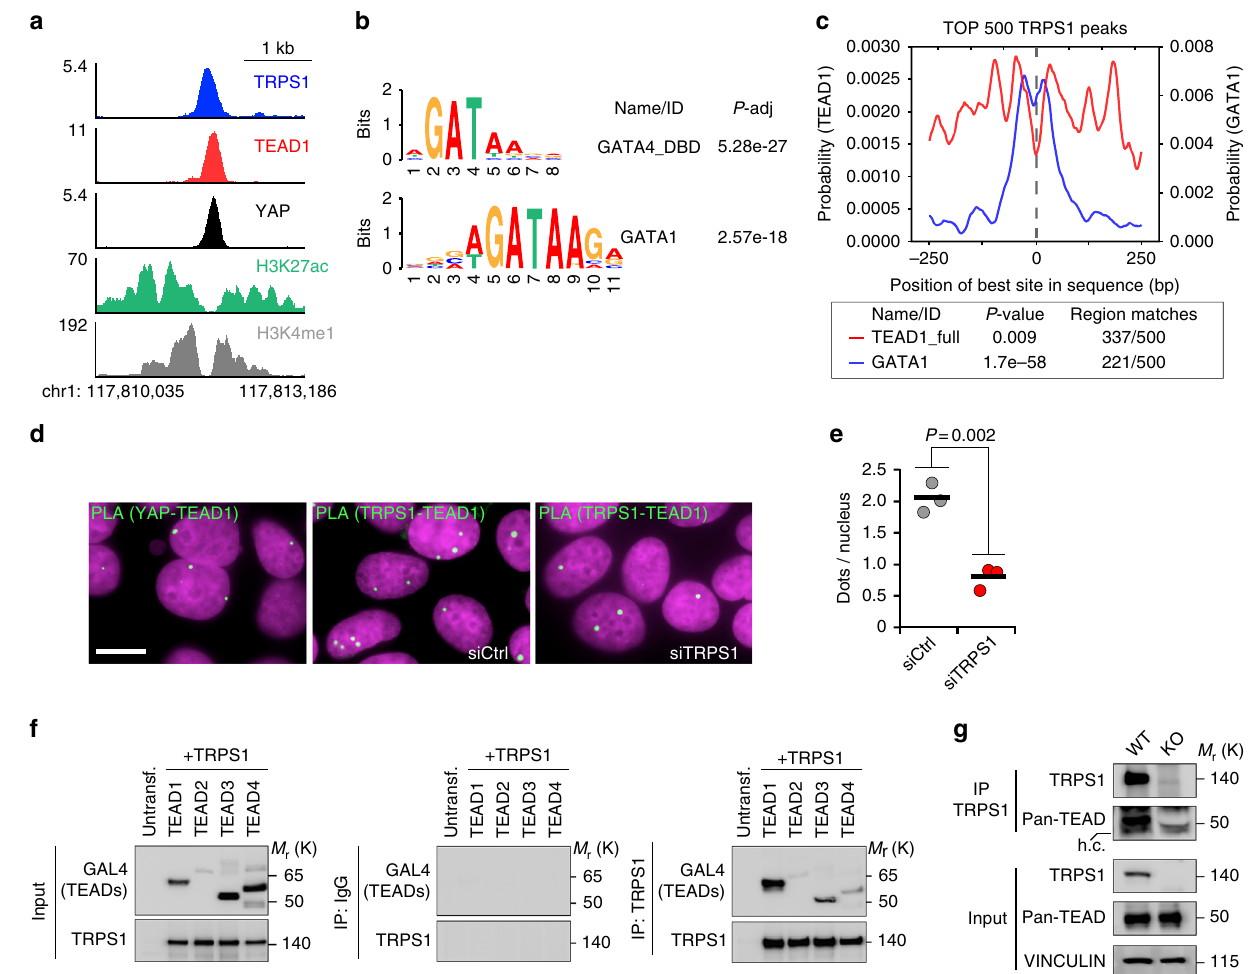
Fig. 4 TRPS1 gets recruited to TEAD sites by cooperative binding. a ChIP-Seq tracks for TRPS1, TEAD1, YAP, H3K27ac and H3K4me1 at the VTCN1 Enhancer region. b Motif enrichment analysis (DREME) for GATA4 and GATA1 binding sites in TRPS1 ChIP peaks. c Centrimo analysis for GATA1 and TEAD1 motifs to identify enriched binding sites surrounding the Top 500 TRPS1 ChIP-Seq peaks. d Representative pictures from proximity ligation assay (PLA) experiments in MCF7 cells. The pictures show PLA signals (in green) for YAP and TEAD (positive control, left) or TEAD1 and TRPS1 after treatment with siRNAs targeting TRPS1 or control siRNAs (siCtrl). e Quanti fi cation of PLA signals for the TEAD1-TRPS1 interaction in MCF7 cells treated with siTRPS1 or siCtrl, respectively. Values are presented as the number of dots per nucleus for each of the three biological replicates. A horizontal bar indicates the average. For quanti fi cation, at least 400 cells per replicate were counted. Student ’ s t -test. f Co-immunoprecipitation experiment from 293T cells co- expressing TRPS1 and the indicated GAL4-tagged TEAD proteins. The lysates were subjected to immunoprecipitations using a TRPS1 antibody or IgG as a control and subsequently analyzed by Western blot. IgG controls and TRPS1 precipitates were analyzed on the same membrane. g Endogenous co- immunoprecipitation experiment from MCF7 WT and KO TRPS1. The lysates were subjected to immunoprecipitations using a TRPS1 antibody and subsequently analyzed by Western blot using a Pan-TEAD antibody; h.c. heavy (Supplementary Fig. 5c). The TRPS1-mediated repression was dependent on the presence of GATA motifs in the ANKRD1 promoter, since TRPS1 was not able to repress a truncated ANKRD1 promoter lacking GATA sites ( ANKRD1 Δ GATA) (Supplementary Fig. 5d). Thus, the ability of TRPS1 to repress YAP/TEAD-dependent target sites is probably dictated by at least two factors: fi rst, a GATA-binding site located in close proximity to from a difference of compartmentalization between the control a YAP/TEAD site; second, a protein – protein interaction between and TRPS1 protein. We fi rst veri fi ed that BirA*-Flag-TRPS1 and TRPS1 and TEAD transcription factors. NLS-BirA*-Flag were both able to induce nuclear biotinylation of target proteins in a time-dependent manner upon biotin addition (Supplementary Fig. 6a, b). After the expression of BirA*-Flag- TRPS1 or NLS-BirA*-Flag, cells were treated with biotin for 18 h, biotinylated proteins were pulled down with streptavidin beads and identi fi ed by mass spectrometry (Fig. 5a, b). This procedure was highly reproducible since the results from three independent